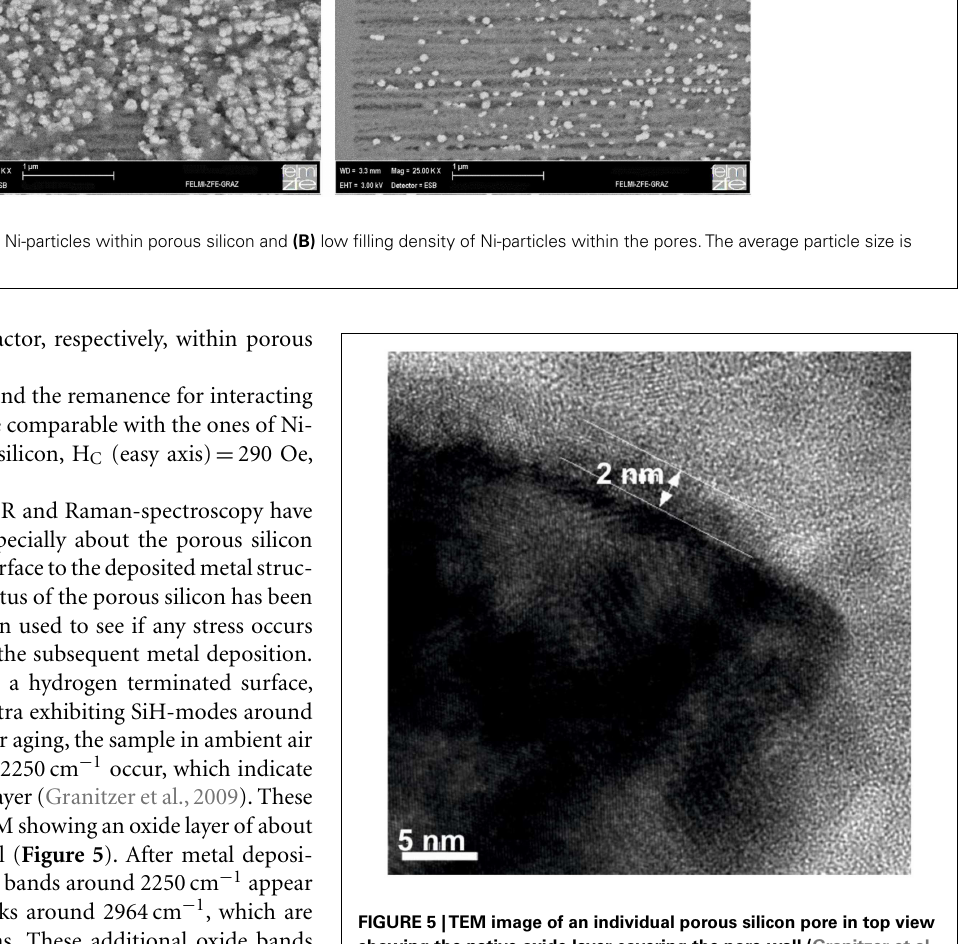
FIGURE 5 |TEM image of an individual porous silicon pore in top view showing the native oxide layer covering the pore-wall (Granitzer et al., 2009)